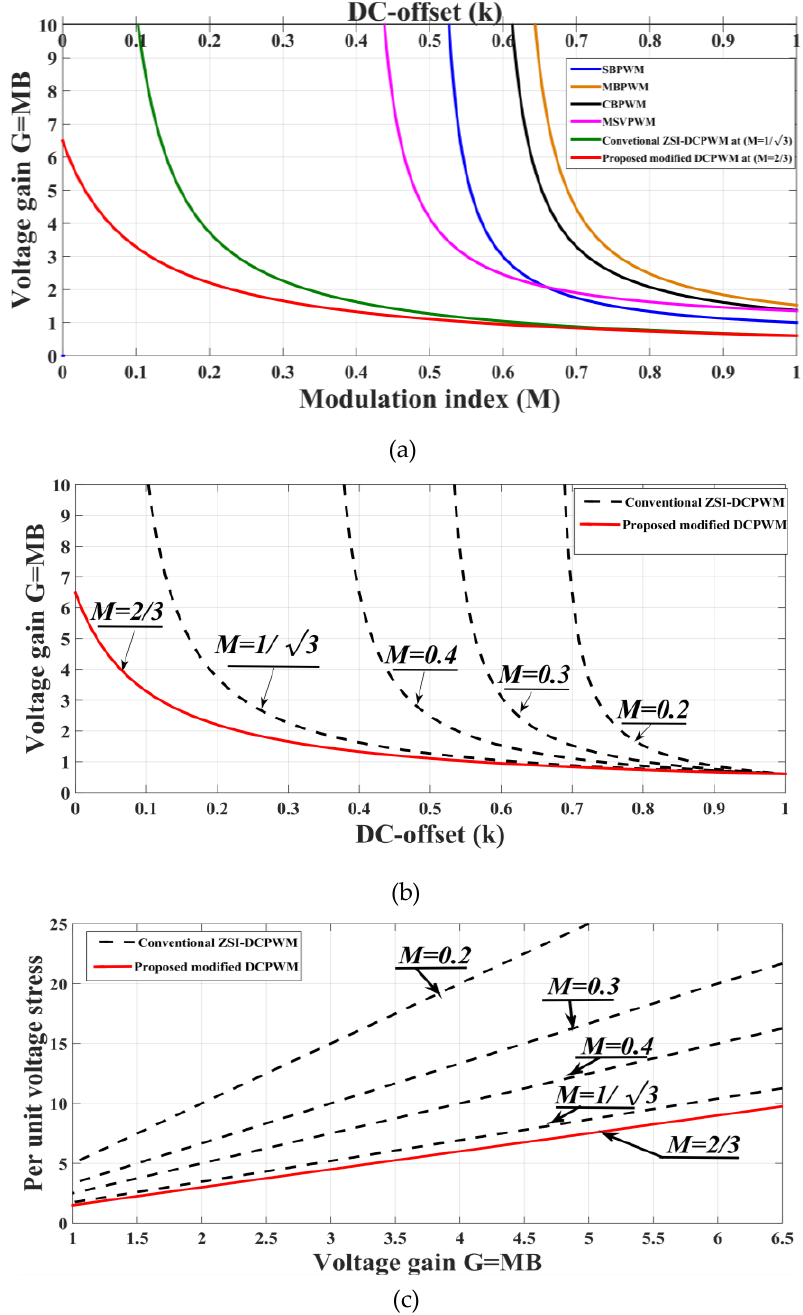
Figure 7. Comparison between various ZSI PWM techniques: ( a ) voltage gain behavior for various PWM techniques, ( b ) voltage gain for conventional and proposed modified DCPWM at different modulation indices, ( c ) per unit voltage stress for conventional and proposed DCPWM at different modulation indices.